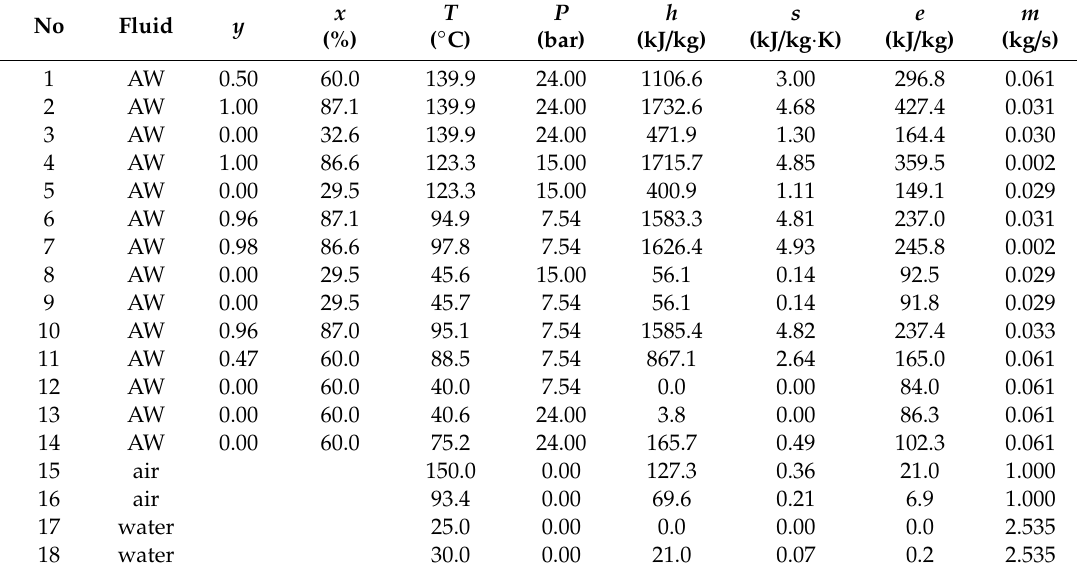
Table 2. Thermodynamic and flow data at each node of the Kalina flash cycle (KFC) under the base